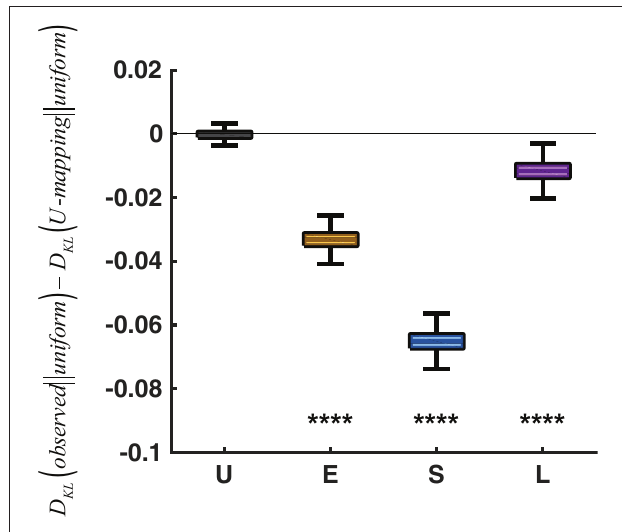
uniform ) denotes FIGURE 7 | Evidence for efficient coding . D KL ( observed k the KL divergence from the uniform distribution over [0, 1] to the observed uniform ) response distribution of a specific condition. D KL ( U - mapping k denotes the KL divergence from the uniform distribution to the response distribution predicted by the p -to- π ( p ) mapping of the Uniform condition. D KL ( observed uniform ) D KL ( U - mapping uniform ) is plotted for each k k − condition, with the Uniform condition serving as a sanity check (i.e., the difference should be 0). A negative difference implies that the p -to- π ( p ) mapping adopted by a specific condition is closer to efficient coding than applying the mapping of the Uniform condition to the condition. In the box plot, the middle line denotes the median across 1,000,000 simulations, the bottom and top lines denote the lower and upper quartiles, and the error bars denote the 99% confidence interval. **** P <